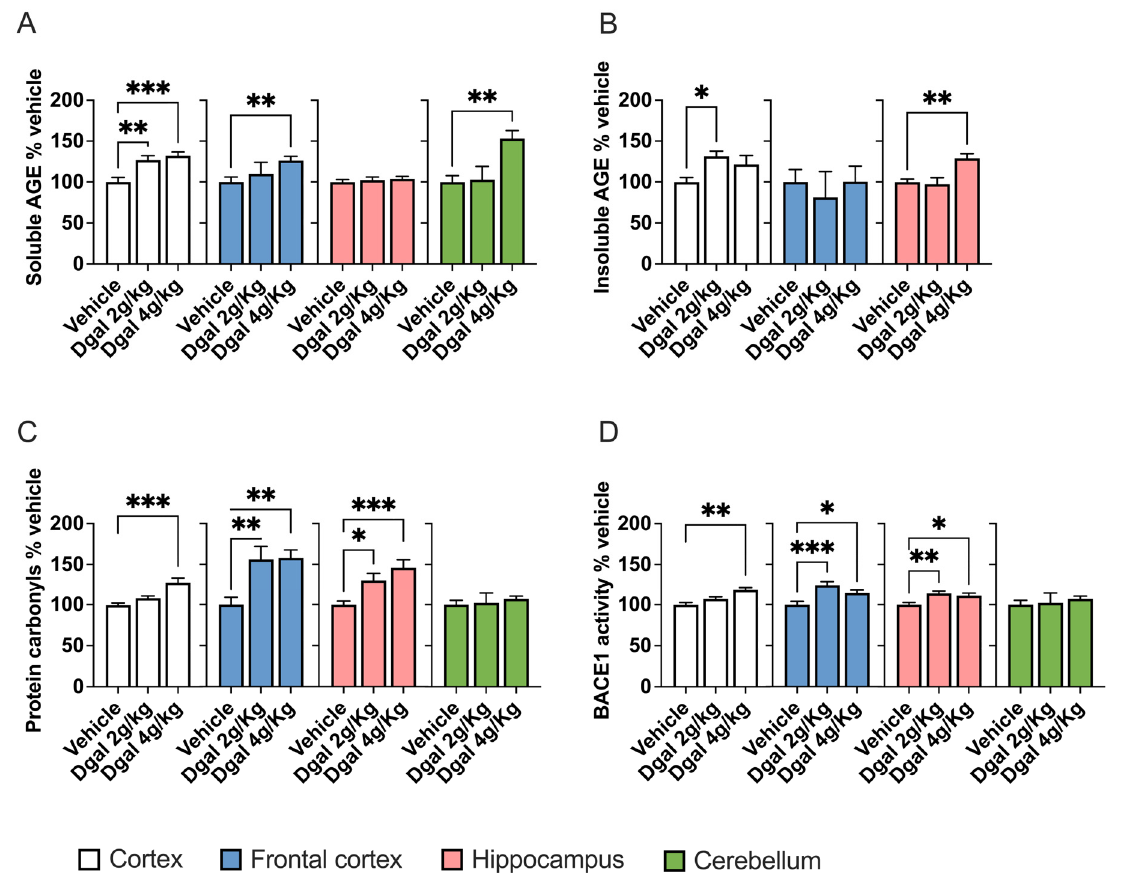
Figure 2. Chronic oDGal treatment elevates AGE, ROS, and BACE1 activity in the brain. ( A ) AGE levels in the soluble cortex, frontal cortex, hippocampus, and cerebellum fractions for mice dosed chronically over 8 weeks with vehicle, 2 g/kg oDGal or 4 g/kg oDGal. Cortex ( F (2, 18) = 10.58, p = 0.0009) and cerebellum ( F (2, 26) = 7.7, p = 0.0024) analyzed by one-way ANOVA followed by Dunnett’s multiple comparison test. FC ( F (2, 14.49) = 5.27, p = 0.019) analyzed by Brown–Forsythe and Welch ANOVA followed by Dunnett’s T3 multiple comparison test, *** p < 0.001, ** p < 0.01. ( B ) AGE levels in the insoluble cortex, frontal cortex, hippocampus, and cerebellum fractions for mice dosed chronically over 8 weeks with vehicle, 2 g/kg oDGal or 4 g/kg oDGal. Data are presented as a mean ± SEM percentage vehicle. Cortex ( F (2, 18) = 3.72, p = 0.046) and hippocampus ( F (2, 26) = 10.04, p = 0.0006) analyzed by one-way ANOVA followed by Dunnett’s multiple comparison test, * p < 0.05; ** p < 0.005. ( C ) PC levels in soluble fractions of cortex, frontal cortex, hippocampus, and cerebellum for mice dosed chronically over 8 weeks with vehicle, 2 g/kg oDGal or 4 g/kg oDGal. Data are presented as a mean ± SEM percentage vehicle. Cortex ( F (2, 18) = 11.85, p = 0.0005), hippocampus ( F (2, 26) = 10.03, p = 0.0005), and FC ( F (2, 26) = 9.174, p = 0.001) analyzed by one-way ANOVA followed by Dunnett’s multiple comparison test, * p < 0.05, ** p < 0.005, *** p < 0.0005. ( D ) Representation of BACE1 activity measured in cortex, frontal cortex, hippocampus, and cerebellum homogenates for mice dosed chronically over 8 weeks with vehicle, 2 g/kg oDGal or 4 g/kg oDGal. Data are presented as a mean ± SEM percentage vehicle. Cortex ( F (2, 18) = 8.94, p = 0.002), FC ( F (2, 22) = 9.5, p = 0.001) and hippocampus ( F ( 2, 26 ) = 7.1, p = 0.0035 ) analyzed by one-way ANOVA followed by Dunnett’s multiple comparison test. Asterix (*) represent significant changes: * p < 0.05, ** p < 0.005, *** p < 0.001. All data are presented as a mean ± SEM percentage